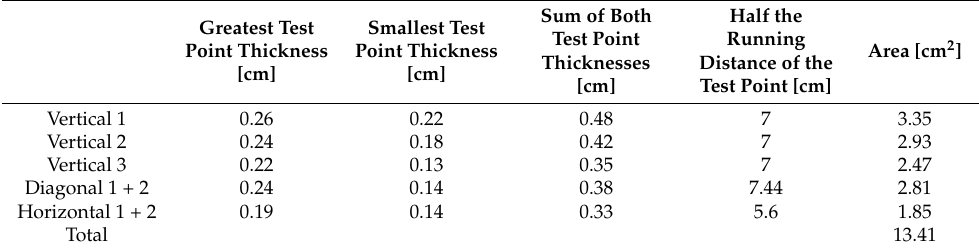
Table 3. Area calculation of the tested visual field fractions during the test